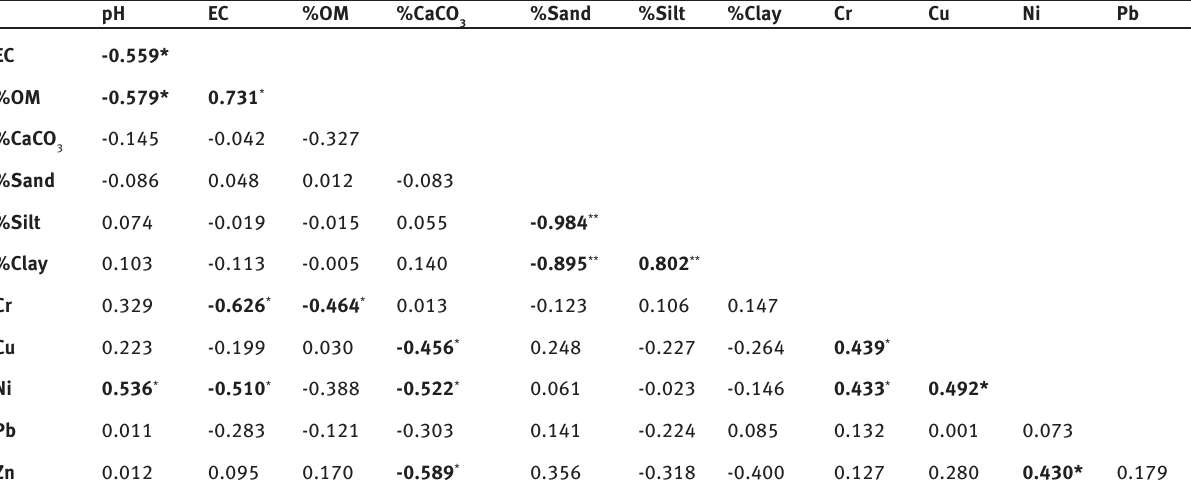
Table 8: Correlation coefficients obtained between the soil properties and heavy metals concentration. pH